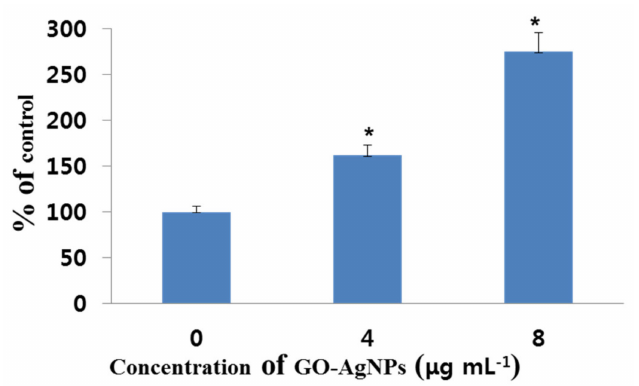
Figure 7. Measurement of malondialdehyde (MDA) production in GO-AgNP-treated cells. Caprine fetal fibroblast cells (CFFCs) were treated with 0, 4, and 8 µ g/mL of GO-AgNPs for 24 h. The percentage of MDA relative to the control group (0 µ g/mL) was determined. Values are presented as the mean ± SD of four independent experiments (* p <